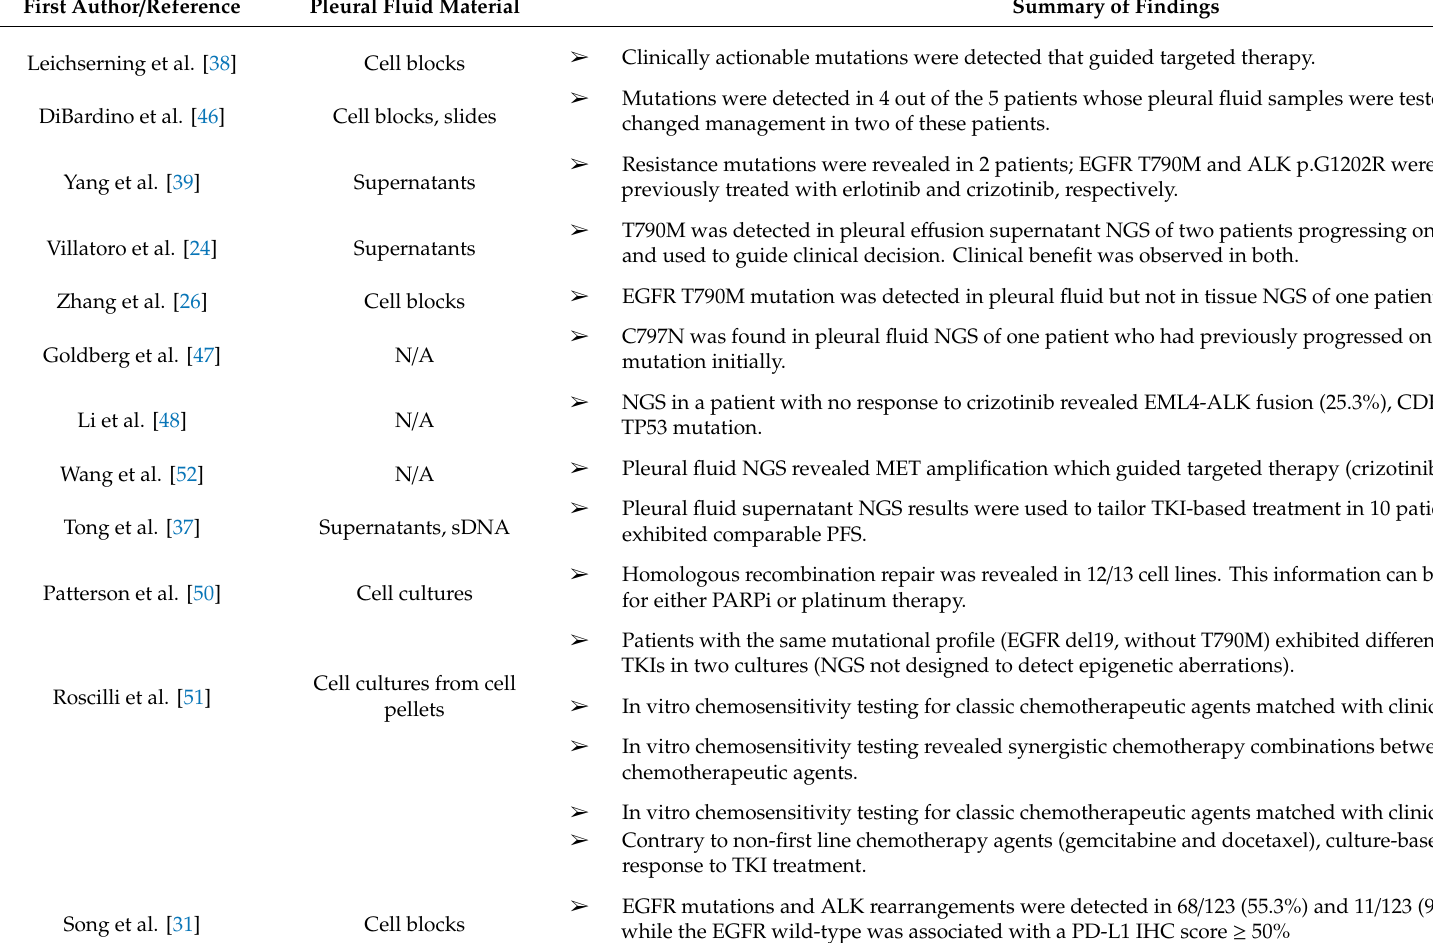
Table 4. NGS in MPE for the evaluation of therapeutic resistance, response, and